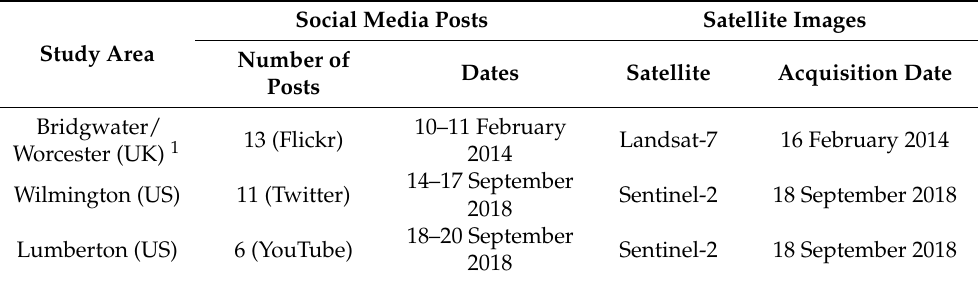
Table 1. Datasets used to produce the flood delineation map for each study